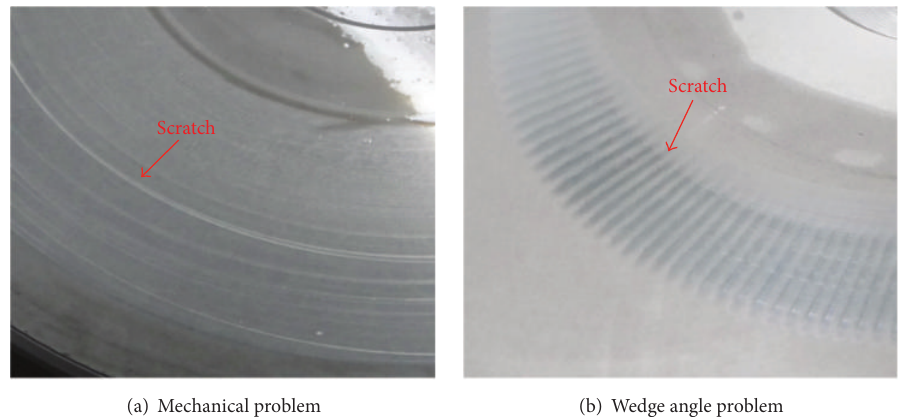
Figure 10: Scratches occurred in “ unhealthy ” lapping processes.